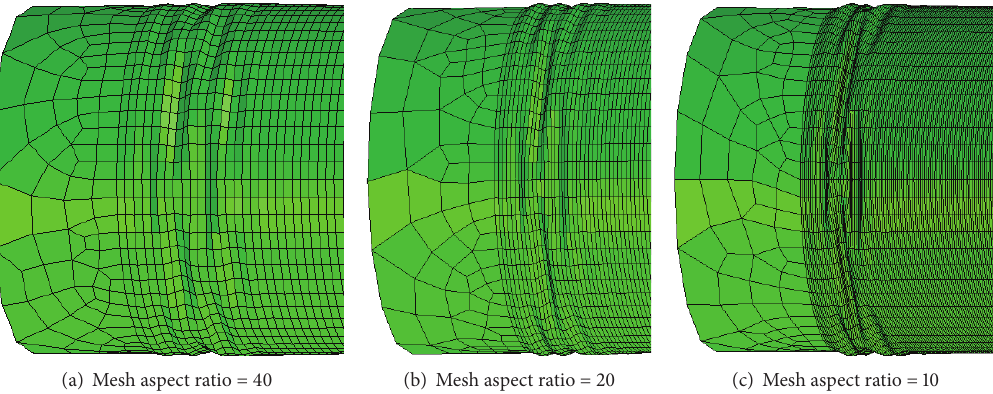
Figure 8: Wrinkles of the inflatable tube with different mesh